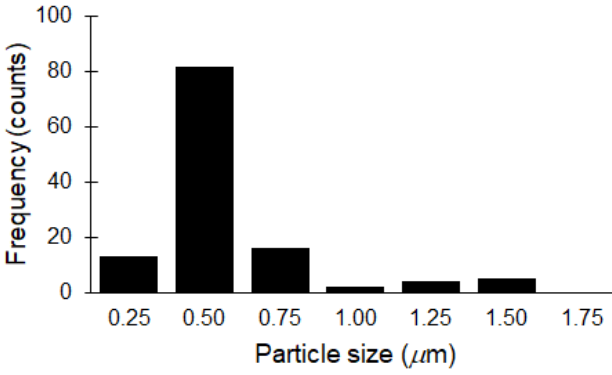
Figure 6. Particle size distribution of GNPs.